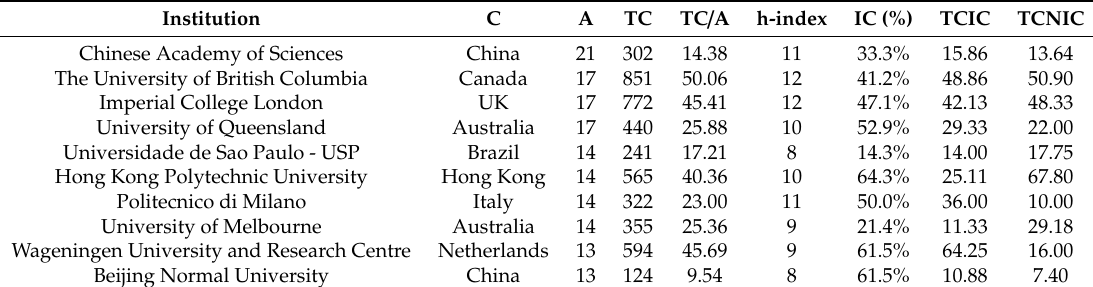
Table 5. Top 10 prolific institutions